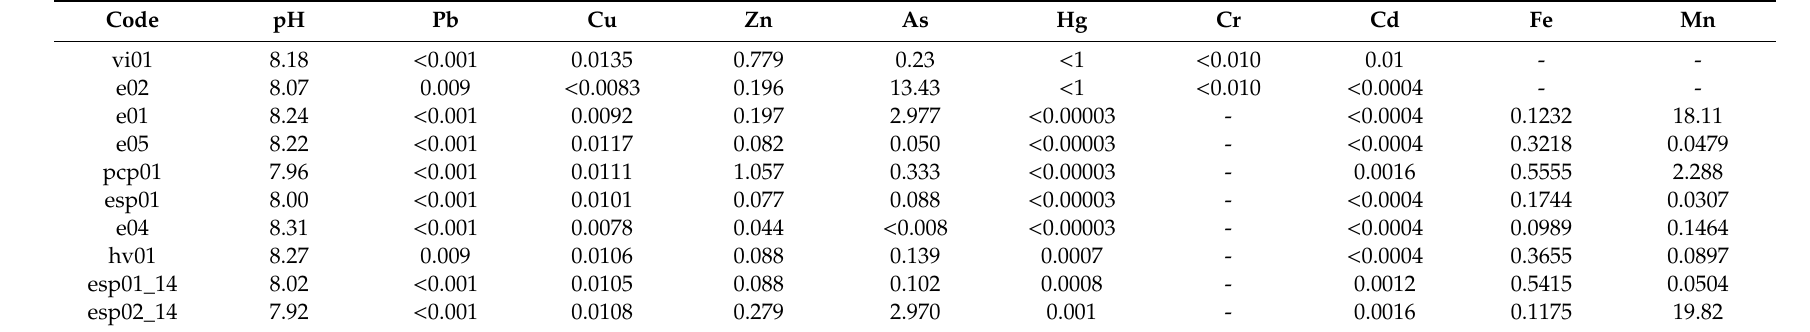
Table A2. Total metal concentrations (mg L − 1 ) in water samples evaluated by OEFA in 2013 in Cunas sub-basin.